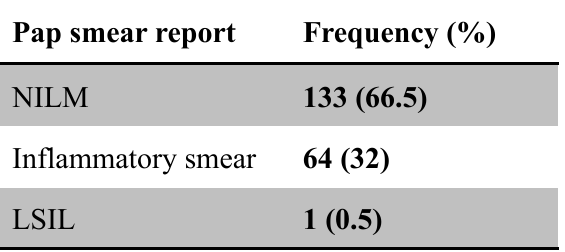
Table 1: Distribution of the study participants based on the PAP smear report (N=198)*